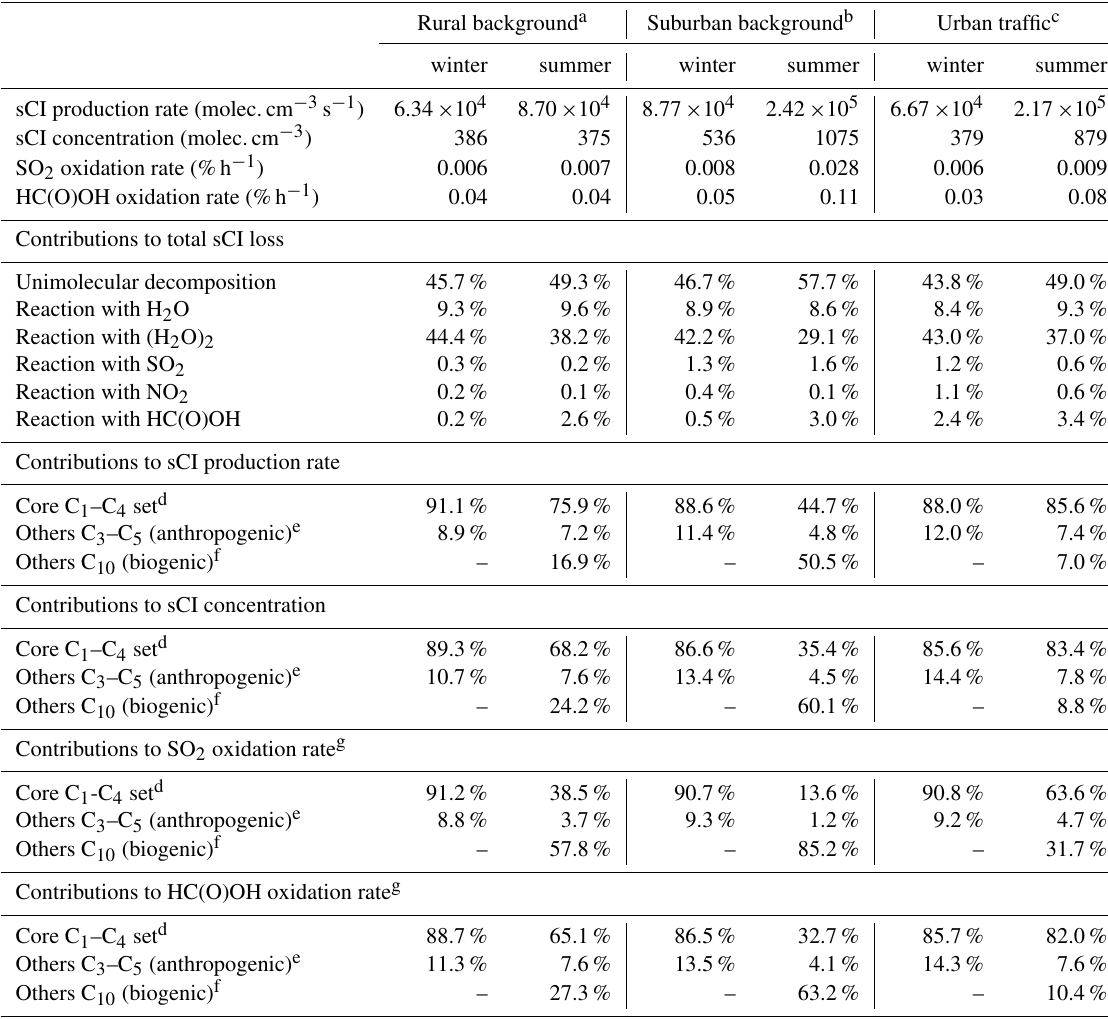
Table 8. Summary of results for the representative ambient calculations (see Sect. 8 and Supplement C for further